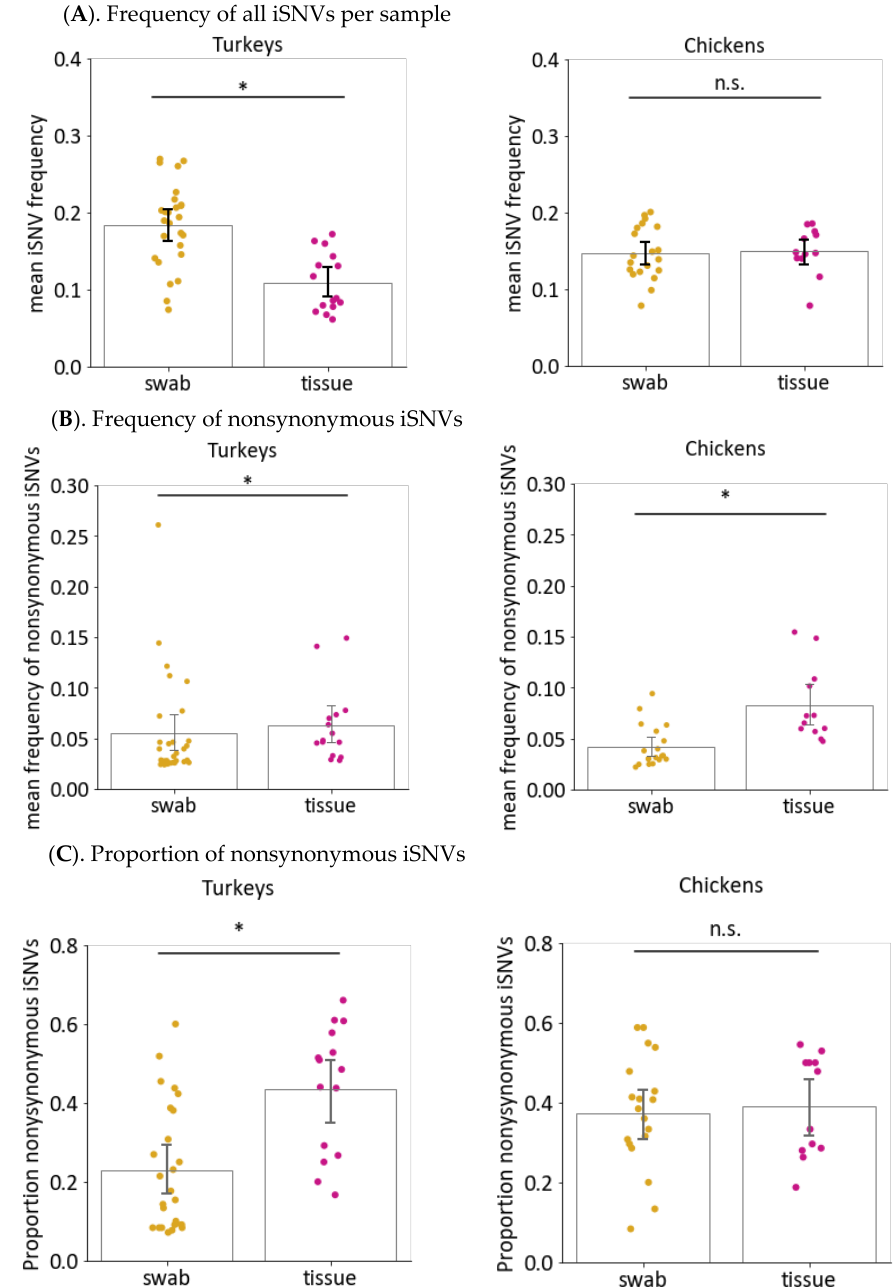
Figure 5. Frequency and proportion of nonsynonymous changes in swabs and tissues of HPAIV- infected turkeys and chickens. For each iSNV, the determination was made by whether an iSNV resulted in an amino acid change in at least one viral protein. The mean frequency of all iSNVs ( A ), and mean frequency ( B ) and proportion of nonsynonymous changes ( C ) in OP swabs or tissues samples from HPAIV-infected birds were then calculated. Asterisks (*) indicate p < 0.05 using Mann – Whitney test. n.s. = not significant with p ≥ 0.05.